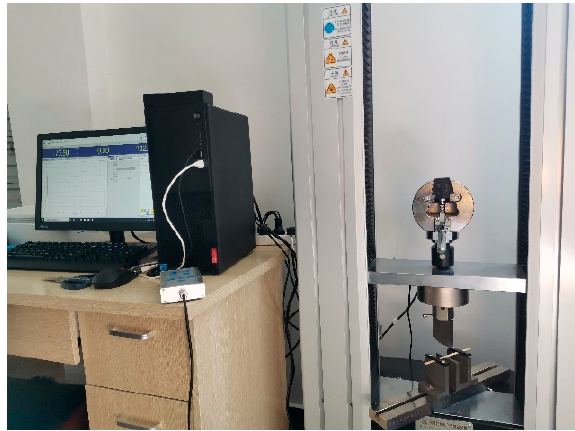
Figure 2. Straw shear force test.